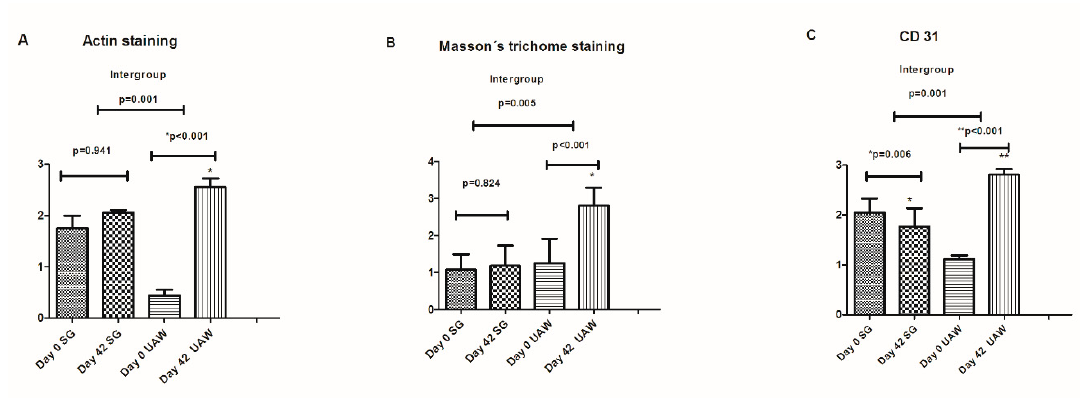
Figure 5. Cellular proliferation analysis. ( A ) Actin staining, ( B ) Masson’s trichrome staining and ( C ). CD31-positive vessels at day 0 and day 42 in both groups of our study population. SG: Surgical group. UAW: Ultrasound group.